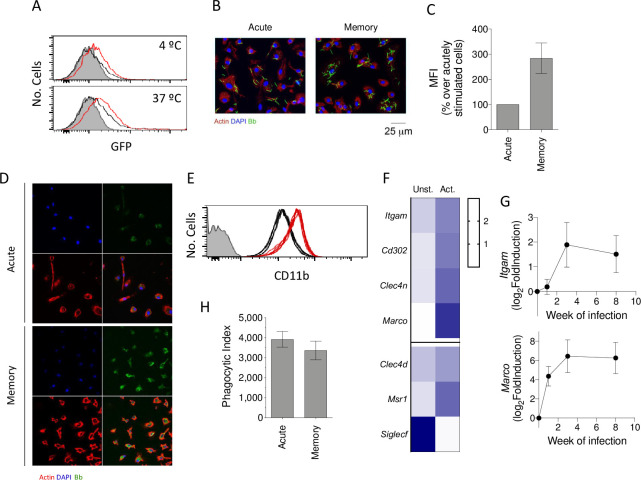
Previously exposed murine macrophages show increased binding and internalization of B. burgdorferi.(A) B. burgdorferi binding (upper panel) and internalization (lower panel) by naïve (black histograms) and memory (red histograms) BMMs. The gray histograms represent BMMs with no spirochetes added. (B) Confocal image showing binding of GFP-B. burgdorferi to acute and memory macrophages. The cells were incubated at 4°C for 2 hours, fixed, and stained with phalloidin and DAPI. (C) Increased MFI of memory macrophages over acute cells, incubated for 2 hours at 4°C. The data are presented as percentage increase over acutely stimulated macrophages. (D) Confocal images showing the internalization of GFP-B. burgdorferi by acute and memory hMacs. The cells were incubated at 37°C for 2 hours, fixed, and stained with phalloidin and DAPI. (E) Expression of CD11b by unexposed (black histograms) and previously experienced (red histograms) macrophages. The figure represents the results of 6 independent mice. (F) Heat map representing expression levels of genes encoding for macrophage receptors comparing unstimulated and B. burgdorferi–exposed BMMs. The blue color intensity (right) represents the relative level of expression. (G) Log2 fold induction of the Itgam (encoding CD11b) and Marco genes in the hearts of infected mice, determined at 0, 7 (1 week), 21 (3 weeks), and 56 (8 weeks) days of infection. Groups of 3–6 mice were used for each time point. (H) Phagocytic index of acute and memory macrophages, as determined by the formula: % GFP cells (test) × MFI (test) − % GFP cells (4°C control) × MFI (4°C control). This figure represents the results from 6 independent experiments including groups of 3–5 mice per experiment. The data underlying the graphs in Fig 3 can be found in S3 Data, GSE125503, and GSE152168. BMM, bone marrow-derived macrophage; GFP, green fluorescent protein; hMac, human monocyte-derived macrophage; MFI, mean fluorescence intensity.